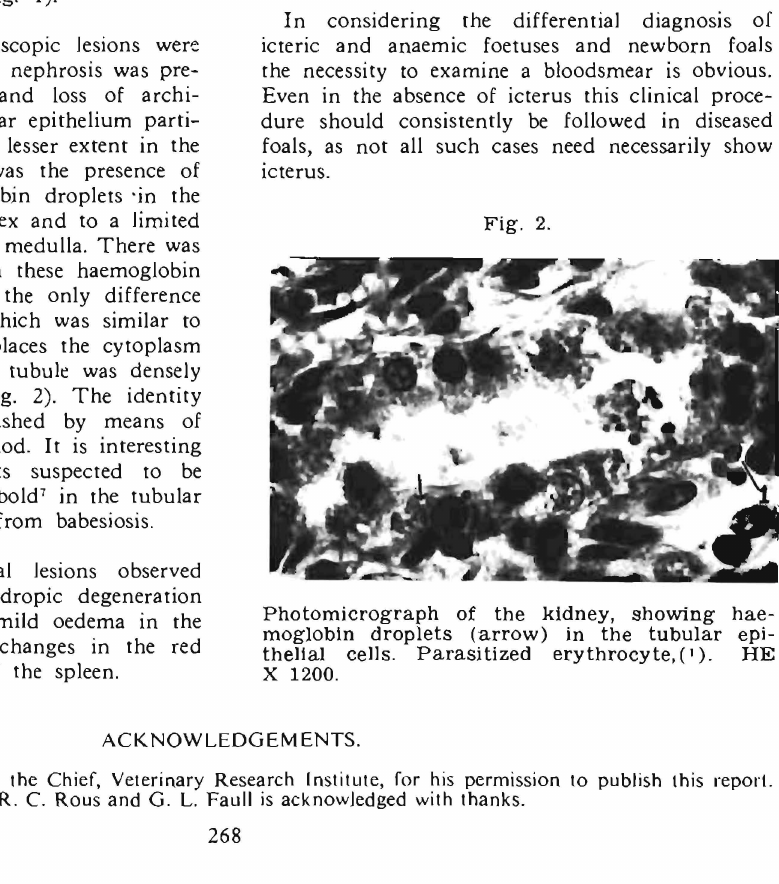
Photomicrograph of the kidney, showing hae moglobin droplets (arrow) in the tubular epi thel1al cells. ParaSitized erythrocyte, (I). HE X